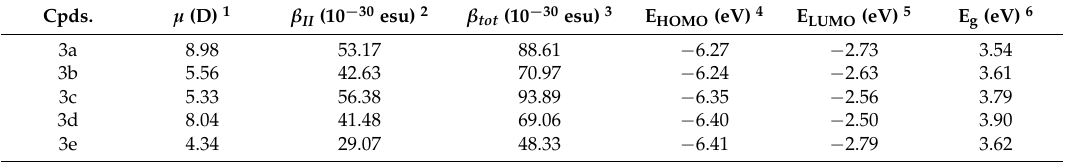
Table 3. Computational results summary of thienylpyridazines 3a – e hyperpolarizability calculations. Cpds.